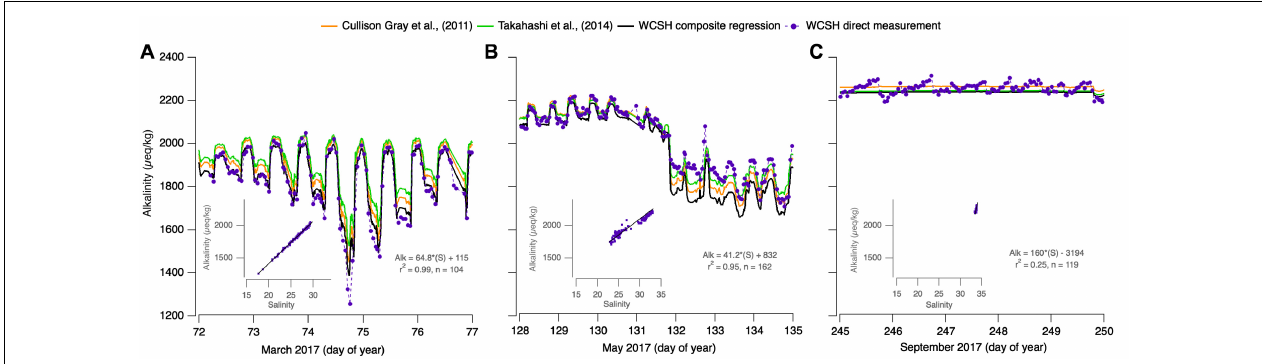
FIGURE 8 | Reconstruction and comparison of directly determined WCSH alkalinity (purple dots connected by a dashed line) and WCSH-composite regression determined alkalinity (black line) against two published regional alkalinity-salinity relationships from Cullison Gray et al. (2011) (orange), and Takahashi et al. (2014) (green). Three intervals are depicted: downwelling interceded by a precipitation event on day 74 (A) , apparent Columbia River plume intrusion days 132–135 (B) , and persistently high salinity during an upwelling interval (C) . Associated alkalinity-salinity regression insets for (A–C) are displayed in gray.